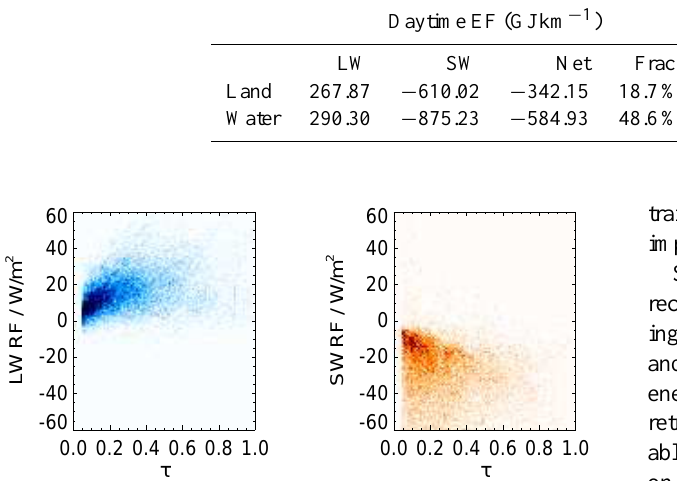
Table 2. Day- and nighttime energy forcing. In percent, the fraction of contrails in each case.